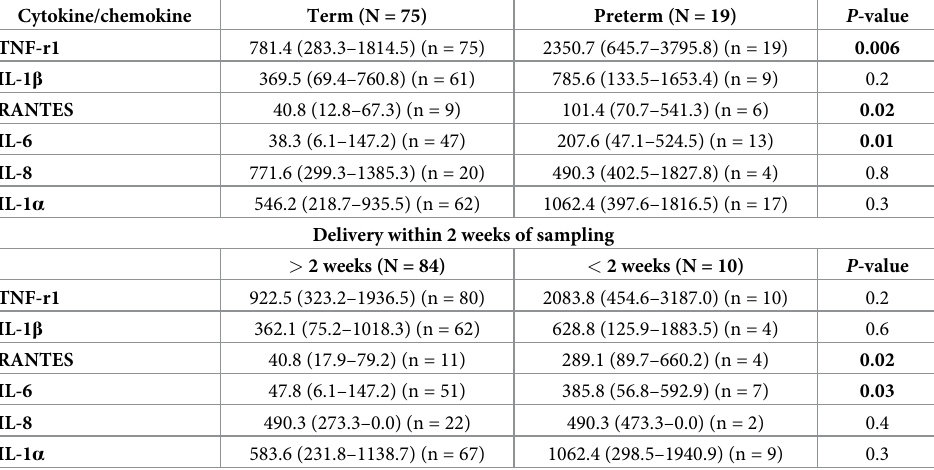
Table 2. Comparison of cervicovaginal fluid cytokine/chemokine concentrations (pg/ml) in relation to delivery outcomes.